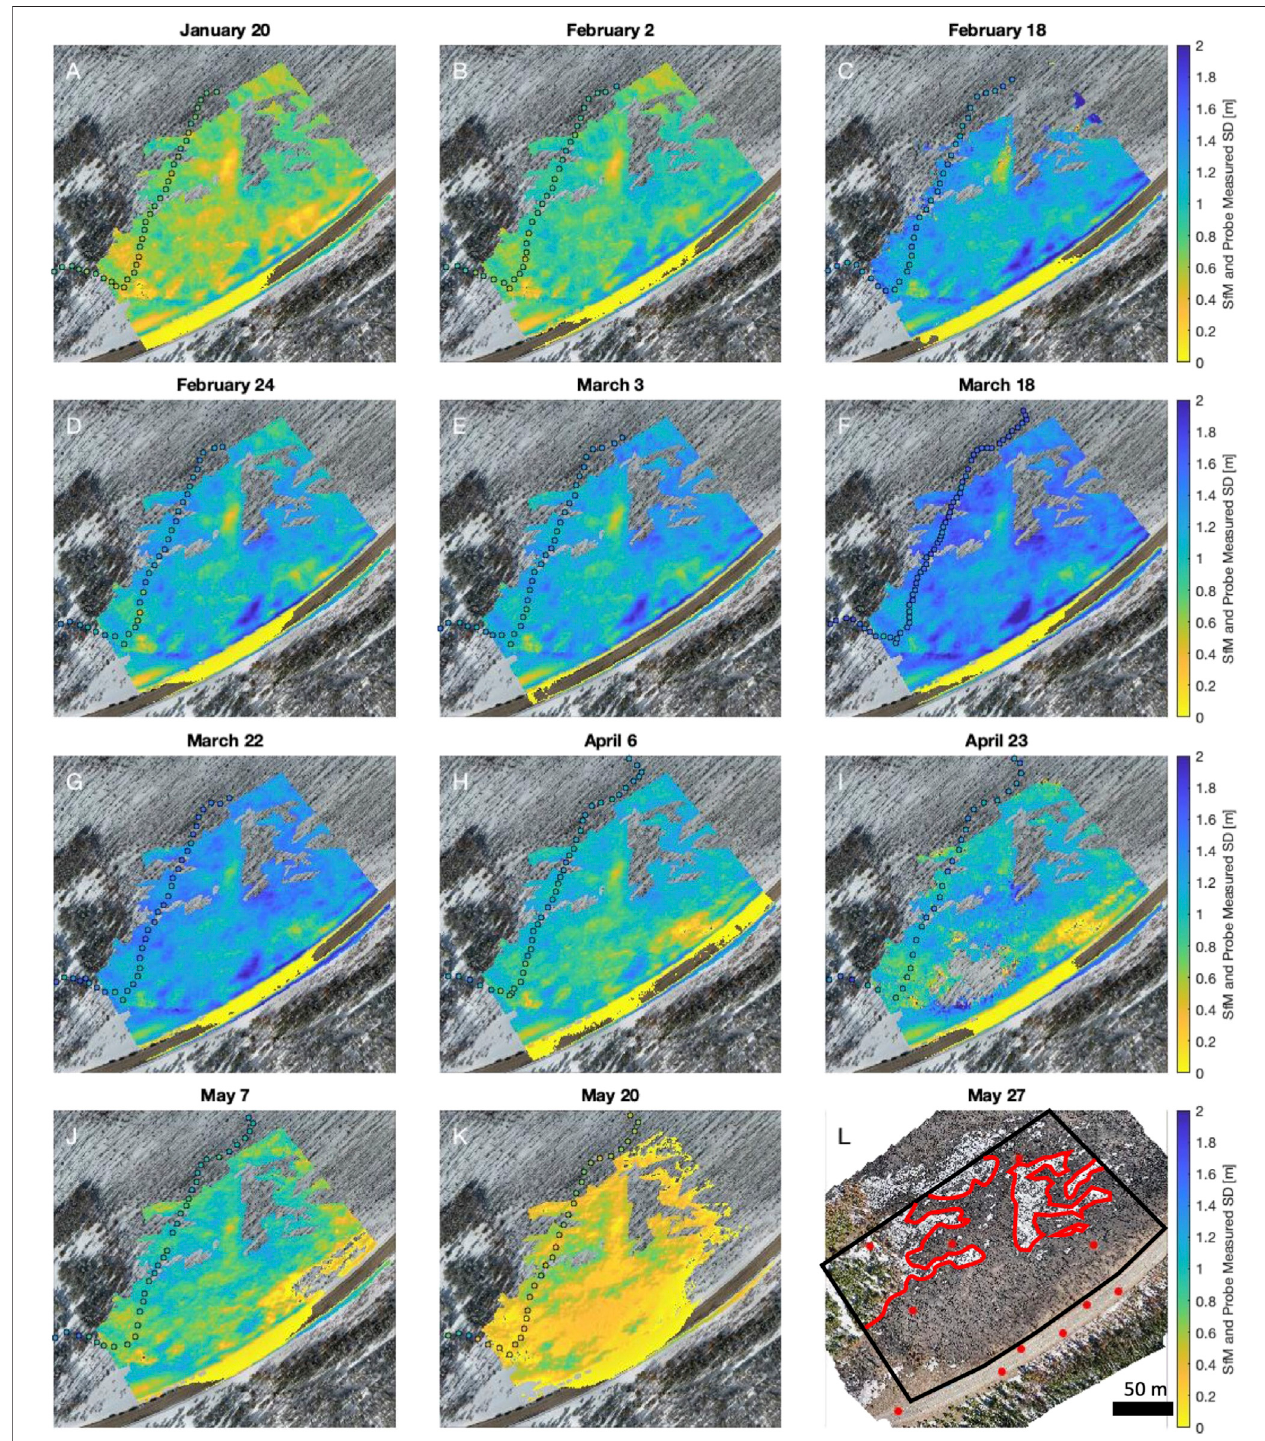
FIGURE 4 | (A – K) Plan view of distributed snow depth observations derived from differencing snow-on and snow-off DSMs. The snow depth rasters have been clipped to remove locations where snow persisted in the “ snow-off ” DSM or signi fi cant forest canopy remained. The colored circles in each plot correspond to snow depths measured by a snow probe. (L) Snow-off orthomosaic from 27 May 2021. The black polygon indicates the study regions and the red polygons indicate the masked regions due to remaining snow cover or closed canopy. The red circles indicate locations of GCPs.